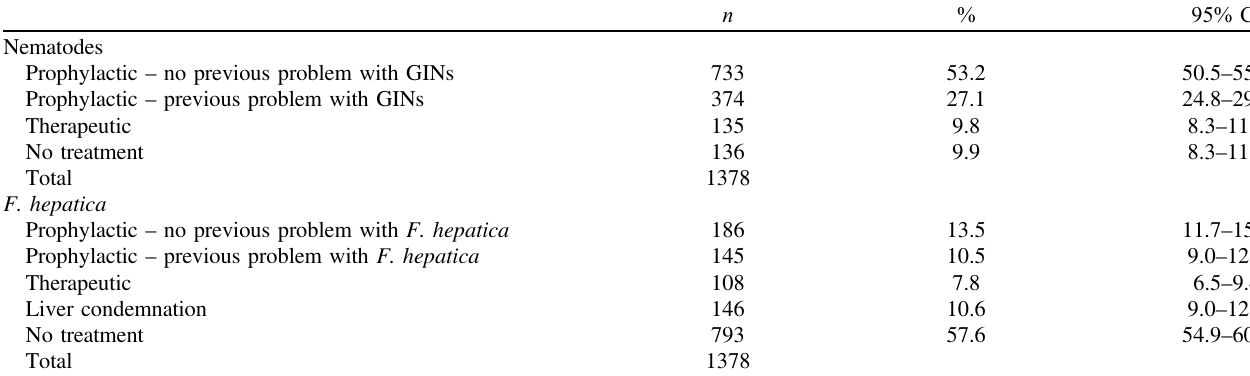
Table 4. Purpose of anthelmintic treatment against nematodes and F. hepatica ( n = 1378).